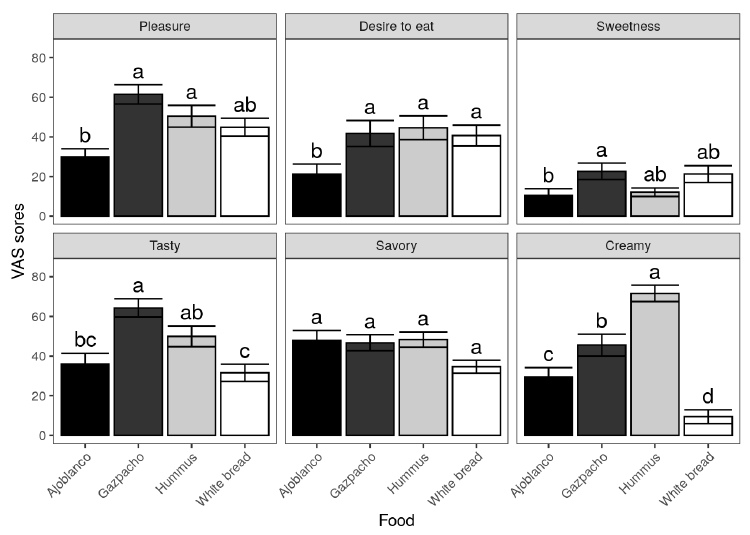
Figure 3. Palatability scores measured by VAS for each tested food. Data are presented as mean values ±